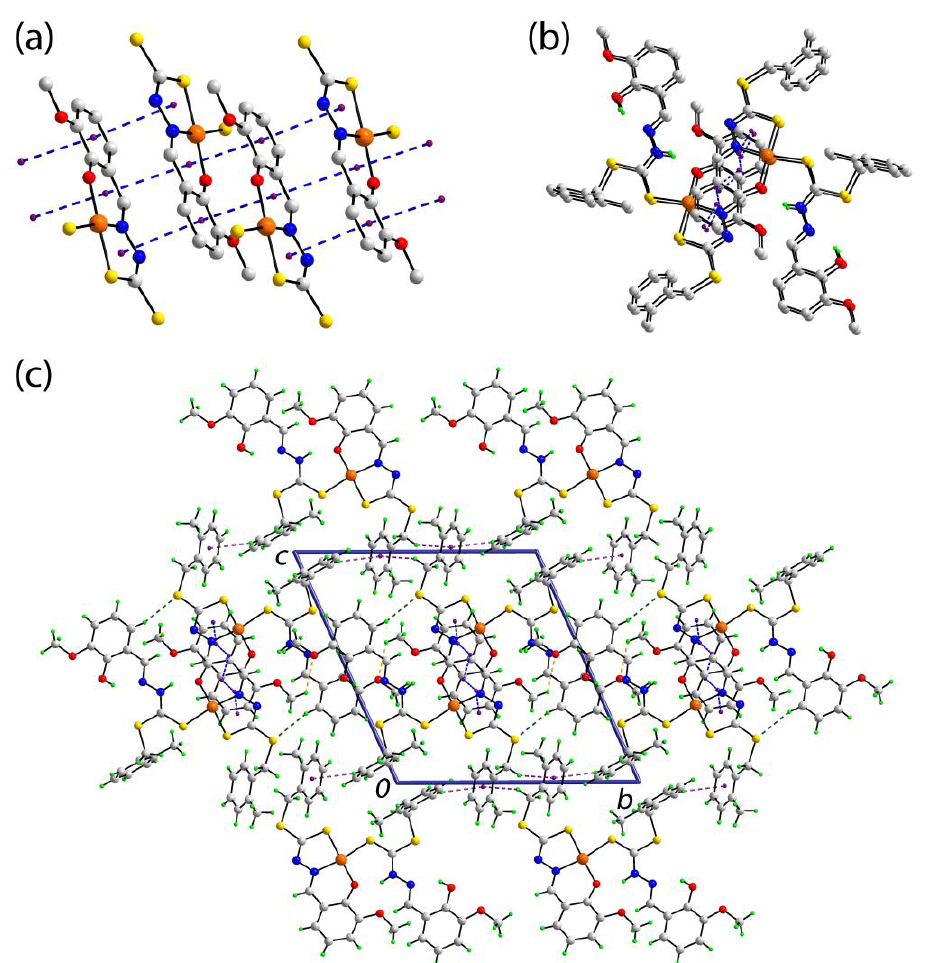
Figure 2. The molecular packing in the crystal of 1 : ( a ) a simplified view of the supramolecular chain sustained by π … π interactions [inter-centroid separations: Cg(Ni,S1,N1,N2,C1) … Cg(C3-C8) i = 3.5231(8) Å (closest atom-to-atom contact between rings occurs between the N1 and C5 i atoms and is 3.370(2) Å ), Cg(Ni,O1,N2,C2-C4) … Cg(C3-C8) ii = 3.4748(8) Å (Ni … C7 ii = 3.3449(16) Å ) and Cg(Ni,O1,N2,C2-C4) … Cg(Ni,O1,N2,C2-C4) i = 3.4718(8) Å (O1 … C2 i = 3.339(2) Å ) for symmetry